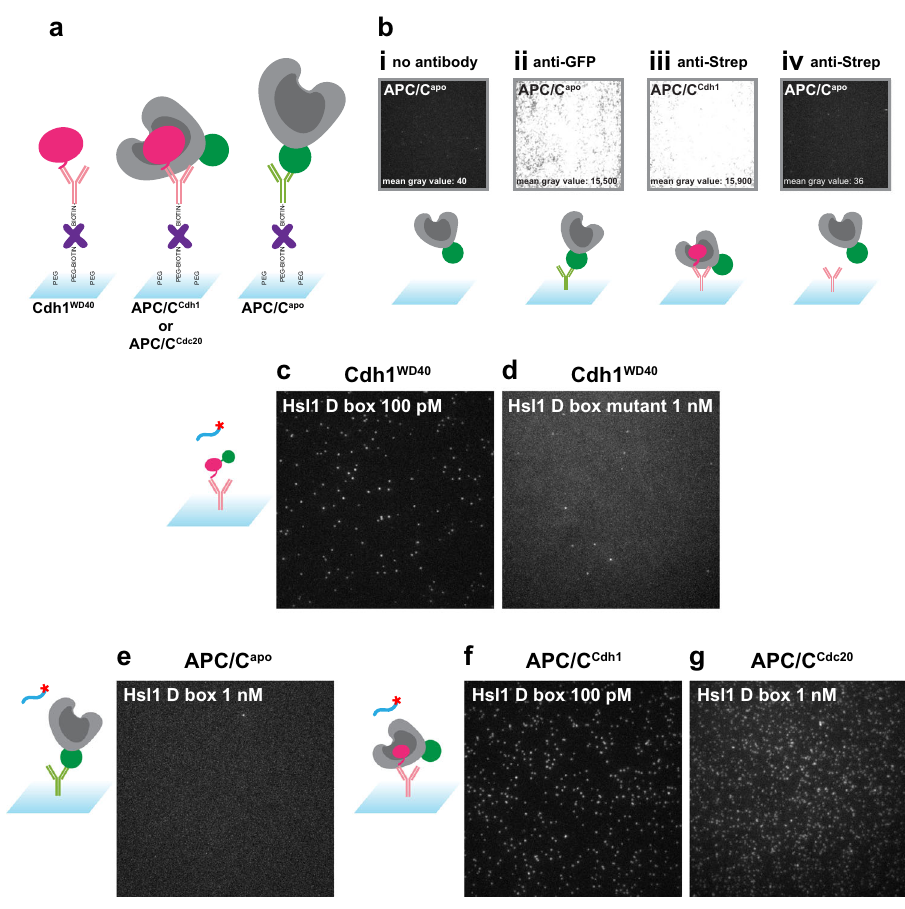
Fig. 2 SMOR assay setup. a Immobilization of binding proteins on the cover glass surface. For activator or for activated APC/C, we used biotinylated anti- Strep-Tag II antibody (pink), which binds the Strep-Tag II on the activator N-terminus. For APC/C apo , we used biotinylated anti-GFP antibody (green), which binds the GFP tag on the Apc1 subunit. Antibody is linked to the biotinylated PEG on the surface using NeutrAvidin (purple). b Fluorescent signal from APC/C-GFP in the absence and presence of antibodies and activator as indicated. c , d Single-molecule interactions of Cy5-labeled Hsl1 D box peptide ( c ) or mutant peptide ( d ) with immobilized GFP-tagged Cdh1 WD40 . e Lack of interactions between Hsl1 D box peptide and immobilized APC/C apo . f , g Single-molecule interactions of Cy5-labeled Hsl1 D box peptide with immobilized APC/C Cdh1 ( f ) or APC/C Cdc20 ( g ). Images in c – g are maximum intensity projections of the fi rst 10 frames of a movie at continuous exposure and 100 ms frame rate (Supplementary Movies 1 –